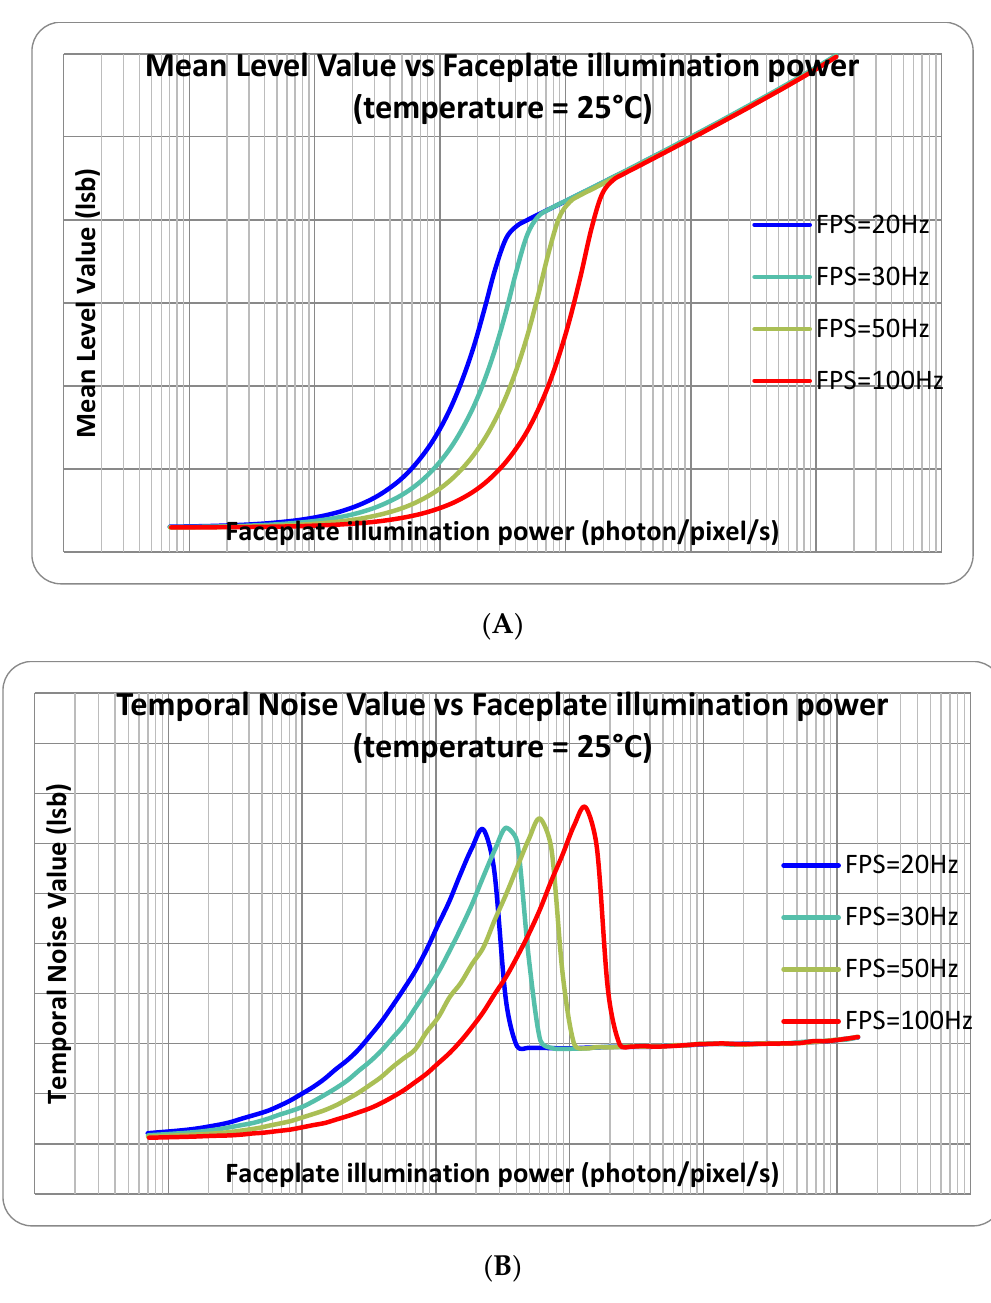
Figure 7. Measured photo-electric responses ( A ) and temporal noises ( B ) from the test chip at room temperature with different exposure times.